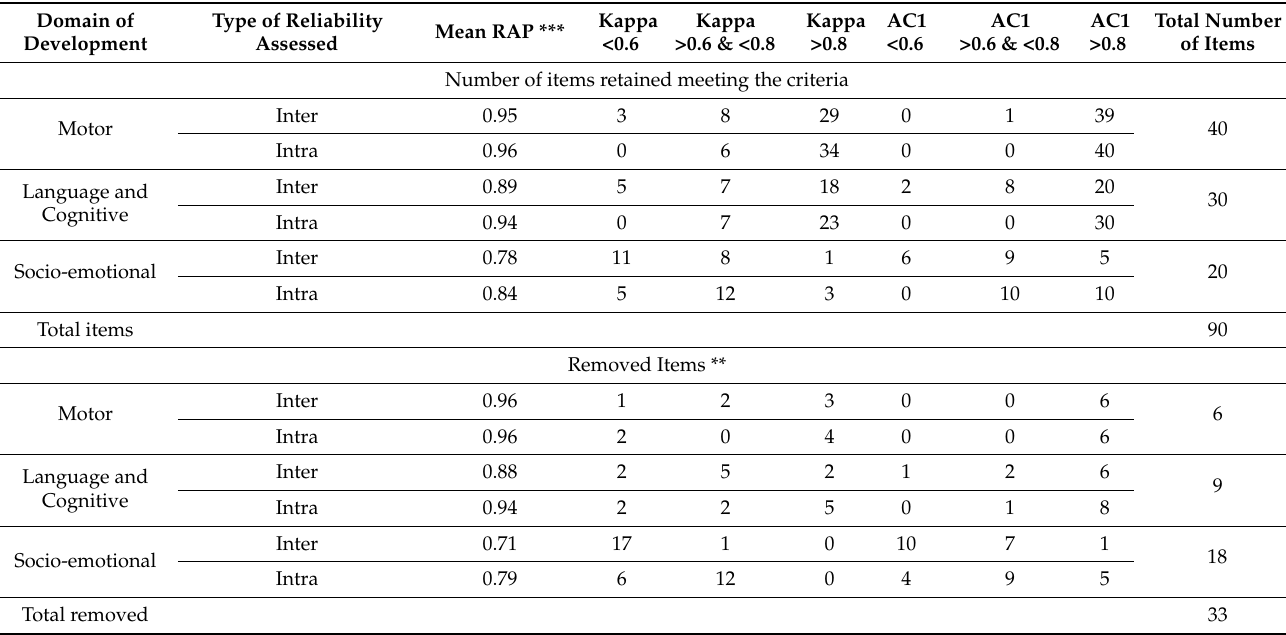
Table 3. Reliability frequencies by domain for WHO IYCD items for the 90 retained items and the 33 removed items. Domain of Type of Reliability Development